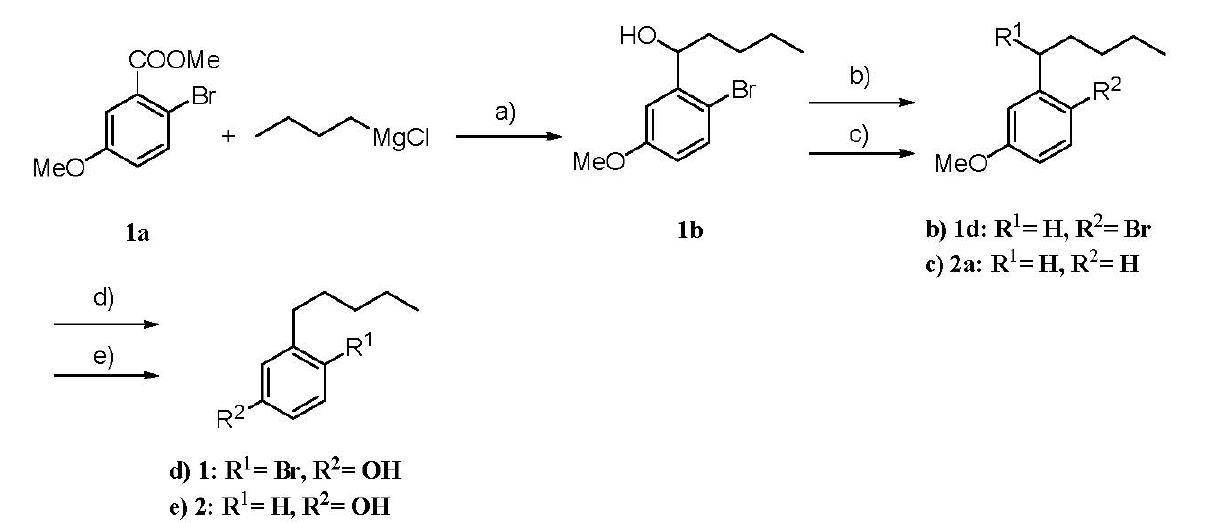
Scheme 1. Synthesis of compounds 1 and 2 a